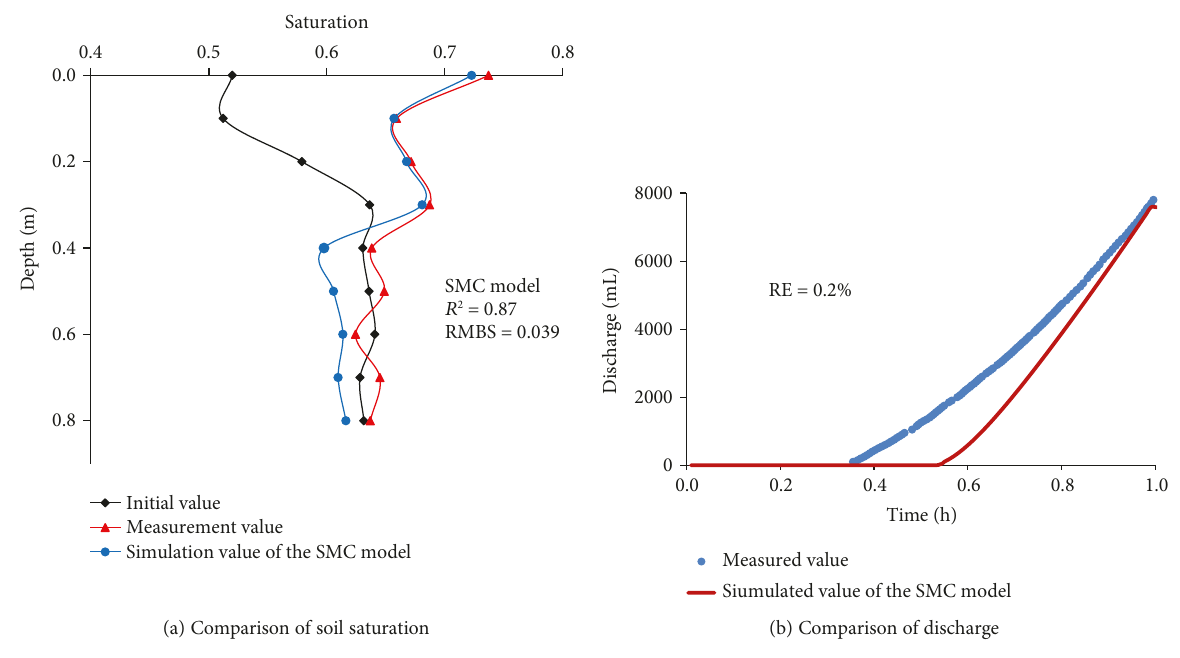
Figure 3: Comparison of the measured and SMC-simulated value of experiment S1. Table 3: Model evaluation parameters of the experiment